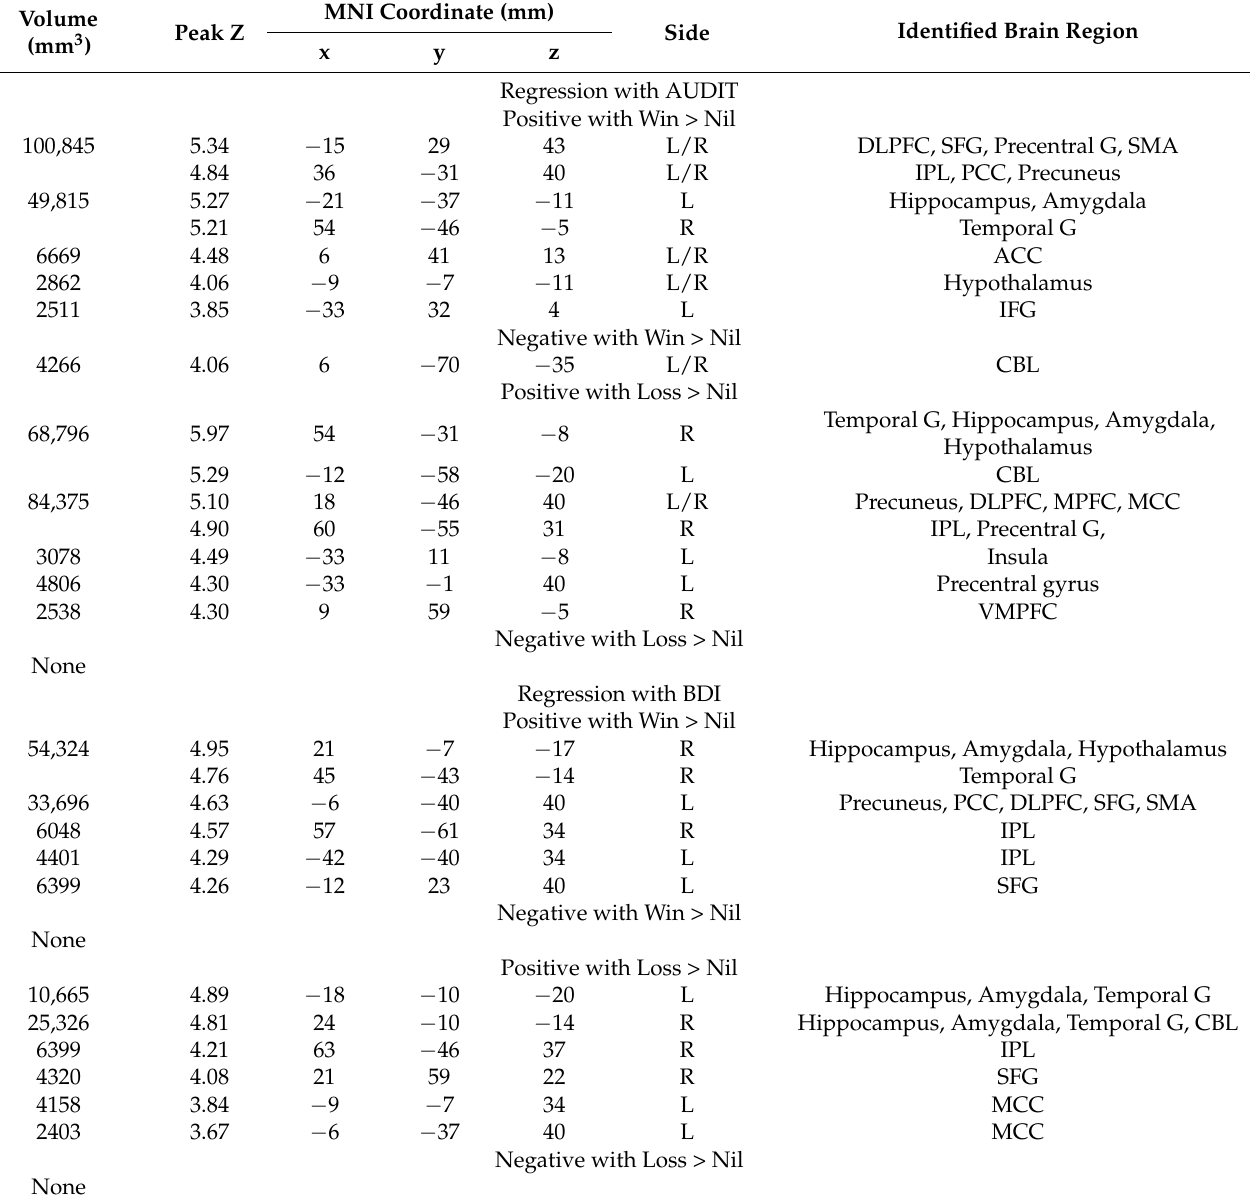
Table 2. Regional activations to win > nil and loss > nil in correlation with AUDIT and BDI-II scores with age, sex, and FTND score as